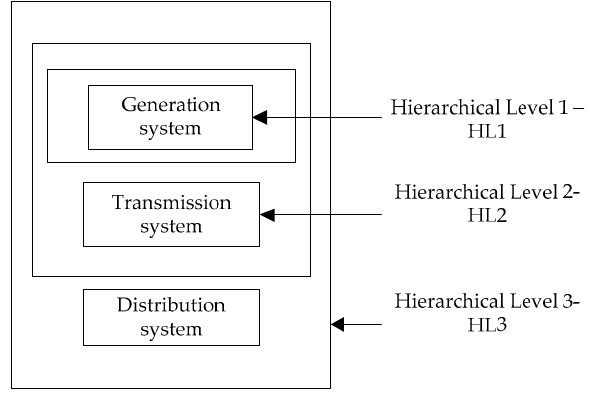
Figure 10 . Power system reliability according to subsystems. Figure 10. Power system reliability according to